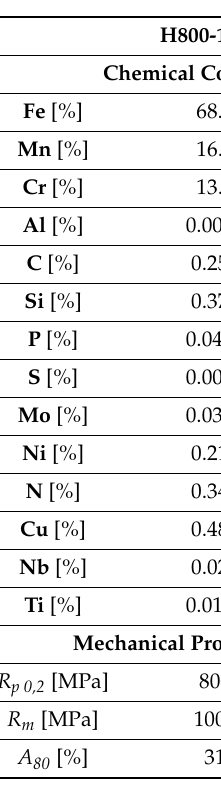
Table 1. Composition of the H800 and CP800 Steels.